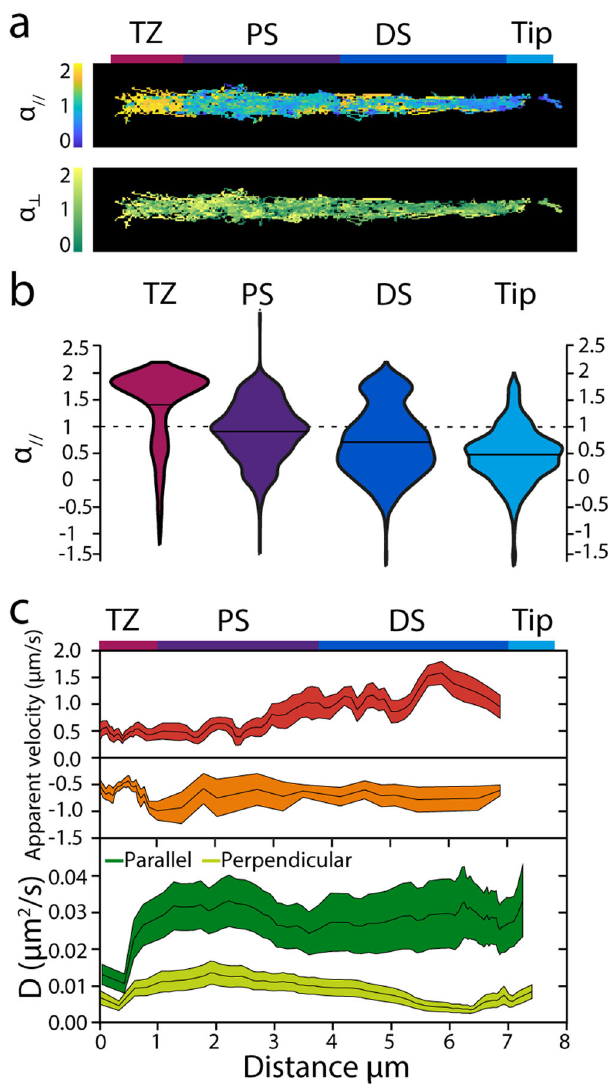
Fig. 4 Analysis of single-molecule OCR-2 trajectories reveals location- speci fi c motility. a Heat maps showing all data points color coded for α // and α ⊥ . Scale b ar: 1 μ m. b Apparent velocities and diffusion coef fi cients of OCR-2 molecules in the phasmid cilia. Top: apparent anterograde and retrograde velocities determined for time points for which α // ≥ 1.4, averaged over 10 displacements. Line thickness represents s.e.m. Bottom: parallel and perpendicular diffusion coef fi cients of OCR-2 determined for time points for which α //, ⊥ <1 averaged locally over 60 displacements. Line thickness represents s.e.m. c Violin plots showing α // for the TZ, PS, DS, and Tip regions of the C. elegans phasmid